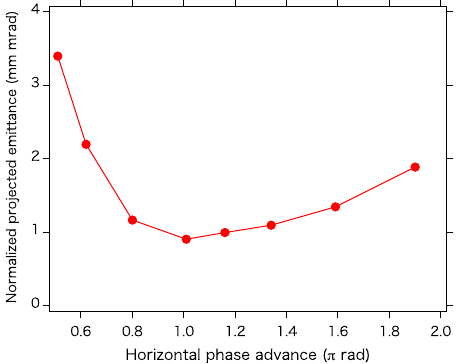
FIG. 7. Stability of the horizontal electron beam orbit as a function of the horizontal phase advance between the two DBA structures of the BL2 dogleg. The red solid circles show the stability of the electron beam orbit in the horizontal phase space measured in front of the BL2 undulators. The horizontal orbit stability of BL3, which is not affected by the CSR effects, is also shown by the blue solid circles for